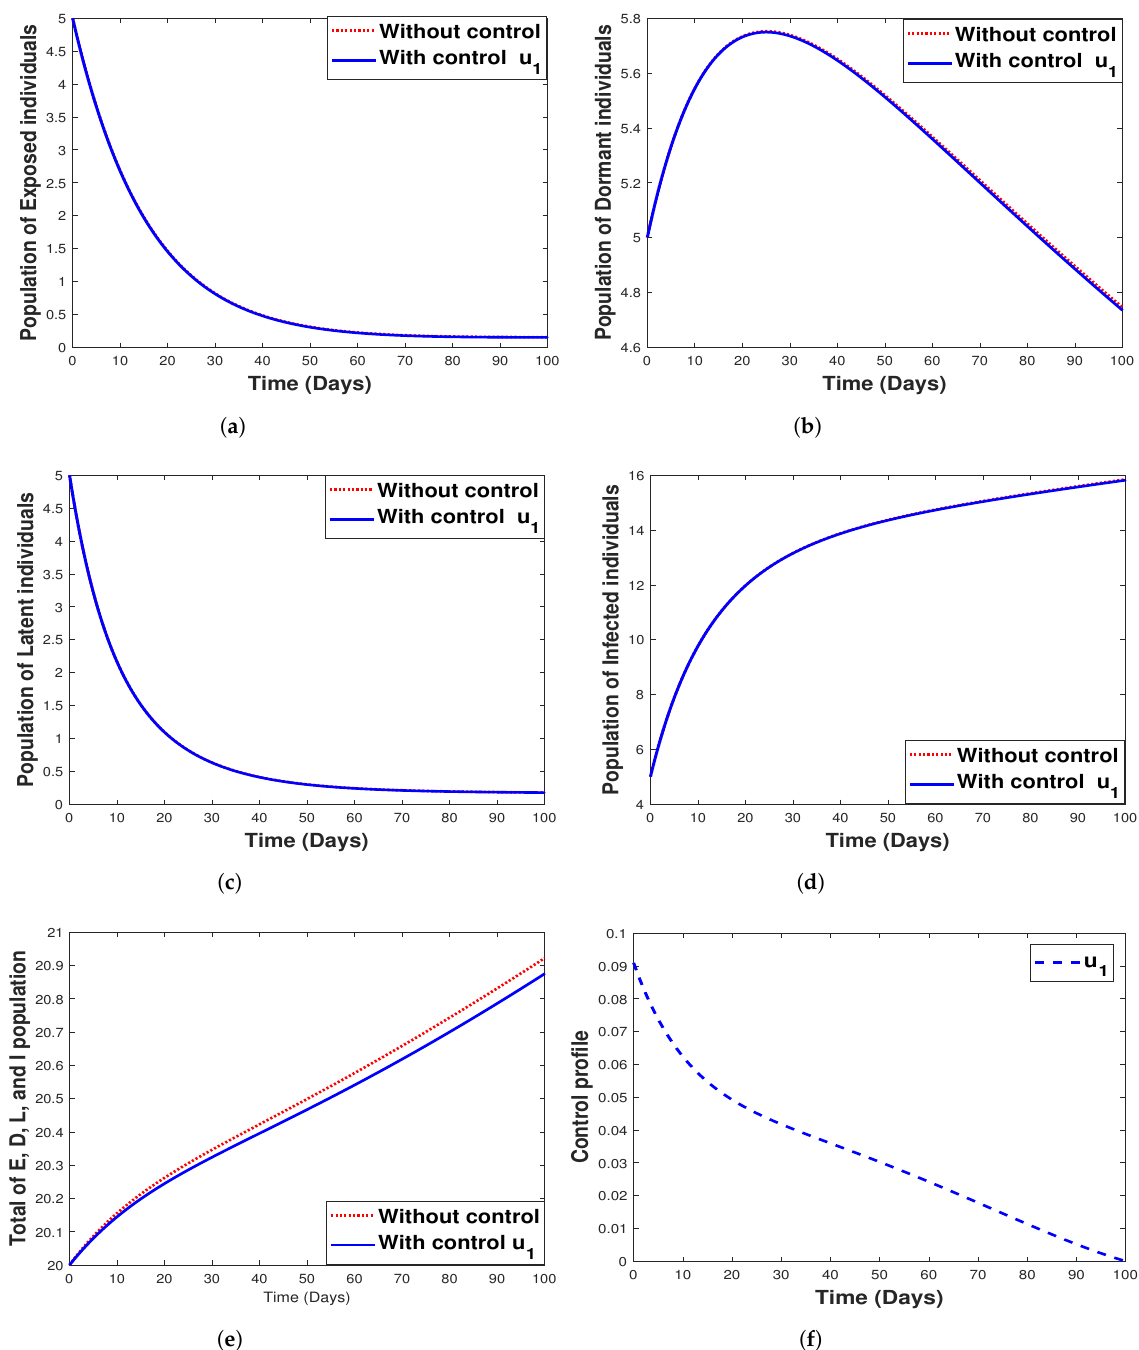
Figure 12. Simulation results for strategy 1 shows the dynamics of exposed compartment, dormant compartment, latent compartment, infected compartment, total of exposed, dormant, latent, and infected population, and the dynamic of control u 1 for subfigure ( a )–( f ),